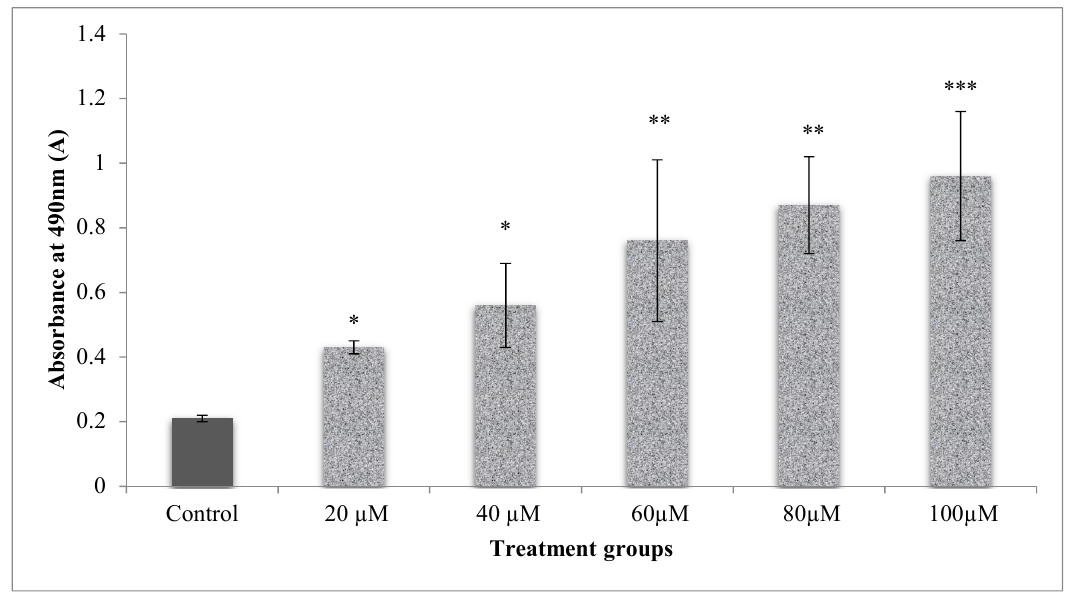
Figure 4. Dose-dependent cytotoxic effect of CA on A549 lung cancer cells as measured by LDH leakage. The test samples showed increased cytotoxicity with an increase in doses when control compared to control samples. Significant dose-dependent cytotoxicity was observed in A549 cells treated with CA (20–100 µM). Values presented as mean ± SE from independent duplicate experiments; n = 4. * p < 0.05, ** p < 0.01 and *** p < 0.001. The energy levels of the cells were measured by calculating the ATP levels of the cells. The energy levels in A549 cells were higher, as indicated by the elevated ATP levels in control cells (Figure 5). Cells that received different doses of CA (20–100 µM) established a significant decline in ATP luminescence as related to control and CA alone treated cells. The reduction in ATP luminescence indicates a reduction in cell proliferation by treatments.